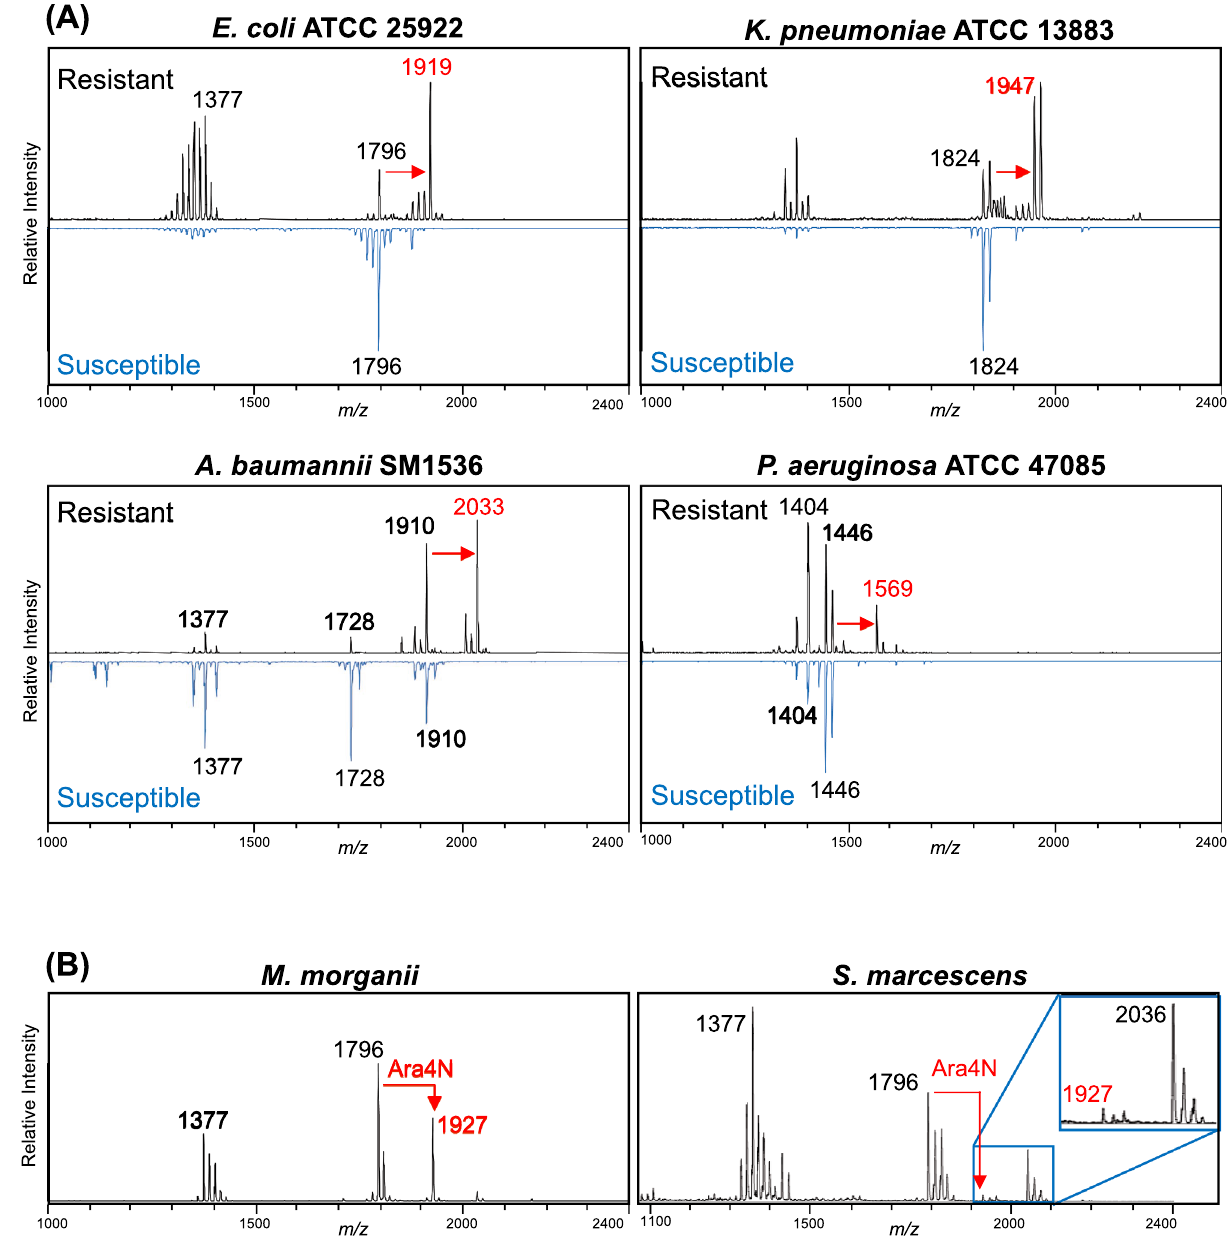
123, shown in red). In resistant spectra, the intensity of the unmodified lipid A base peak is less than that of the modified ion, increasing the relative intensity of other ions in the spectra, especially ions between 1300 and 1400 m /z in E. coli and K. pneumonia . This effect is not clear in A. baumannii and P. aeruginosa, because in each case the intensity of the most prominent unmodified lipid A ion is similar to the intensity of the modified